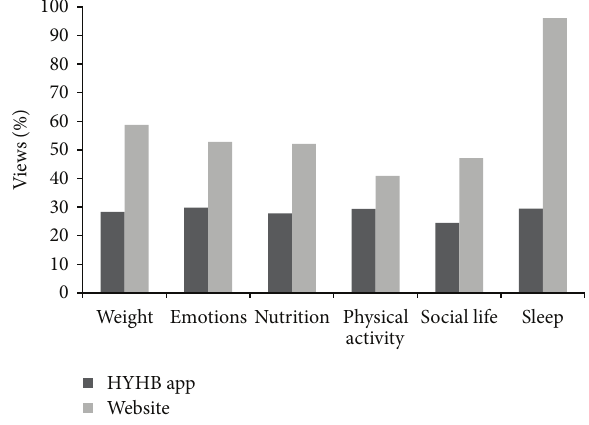
Figure 4: Topics of Ngala Healthy You, Healthy Baby app self- assessments and antenatal and postnatal website